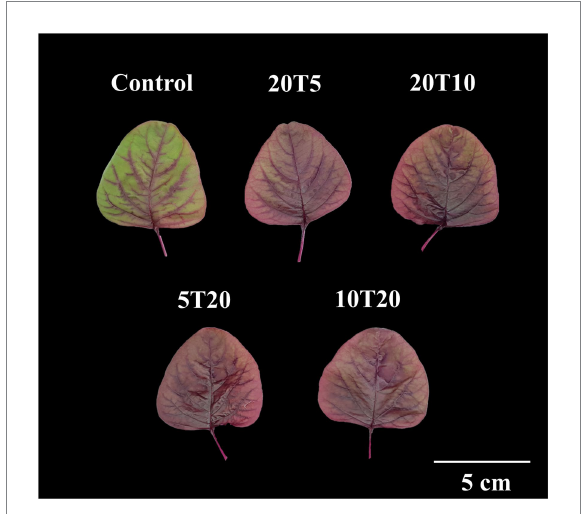
FIGURE 5 Morphology of amaranth leaves treated with different short-term root-zone temperatures (RZT) treatments for 3 days (Experiment 2). The seedlings that were subjected to 2 days of an RZT of 20 ° C followed by 1 day of RZTs of 5 or 10 ° C are designated as 20 T5 and 20 T10, respectively. The seedlings that were treated at 5 or 10 ° C for 1 day, then subjected to an RZT of 20 ° C for 2 days, are illustrated as 5 T20 and 10 T20.